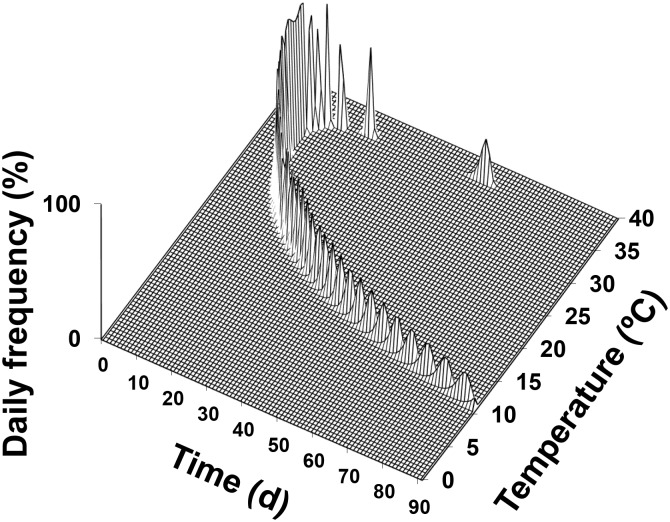
Simulation of daily frequency (%) of C. krombeini adult emergence from an egg cohort in relation to constant temperature (°C) and time (day).